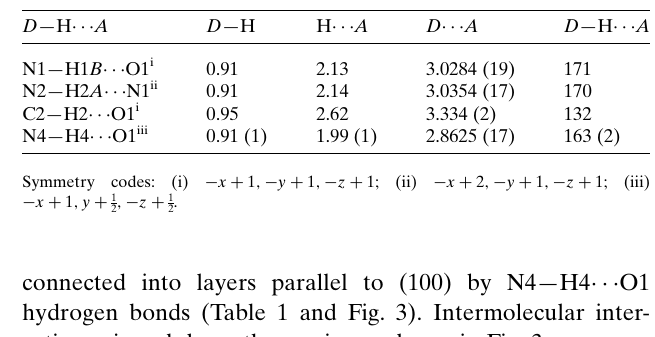
Table 1 Hydrogen-bond geometry (A˚ , (cid:3) ).